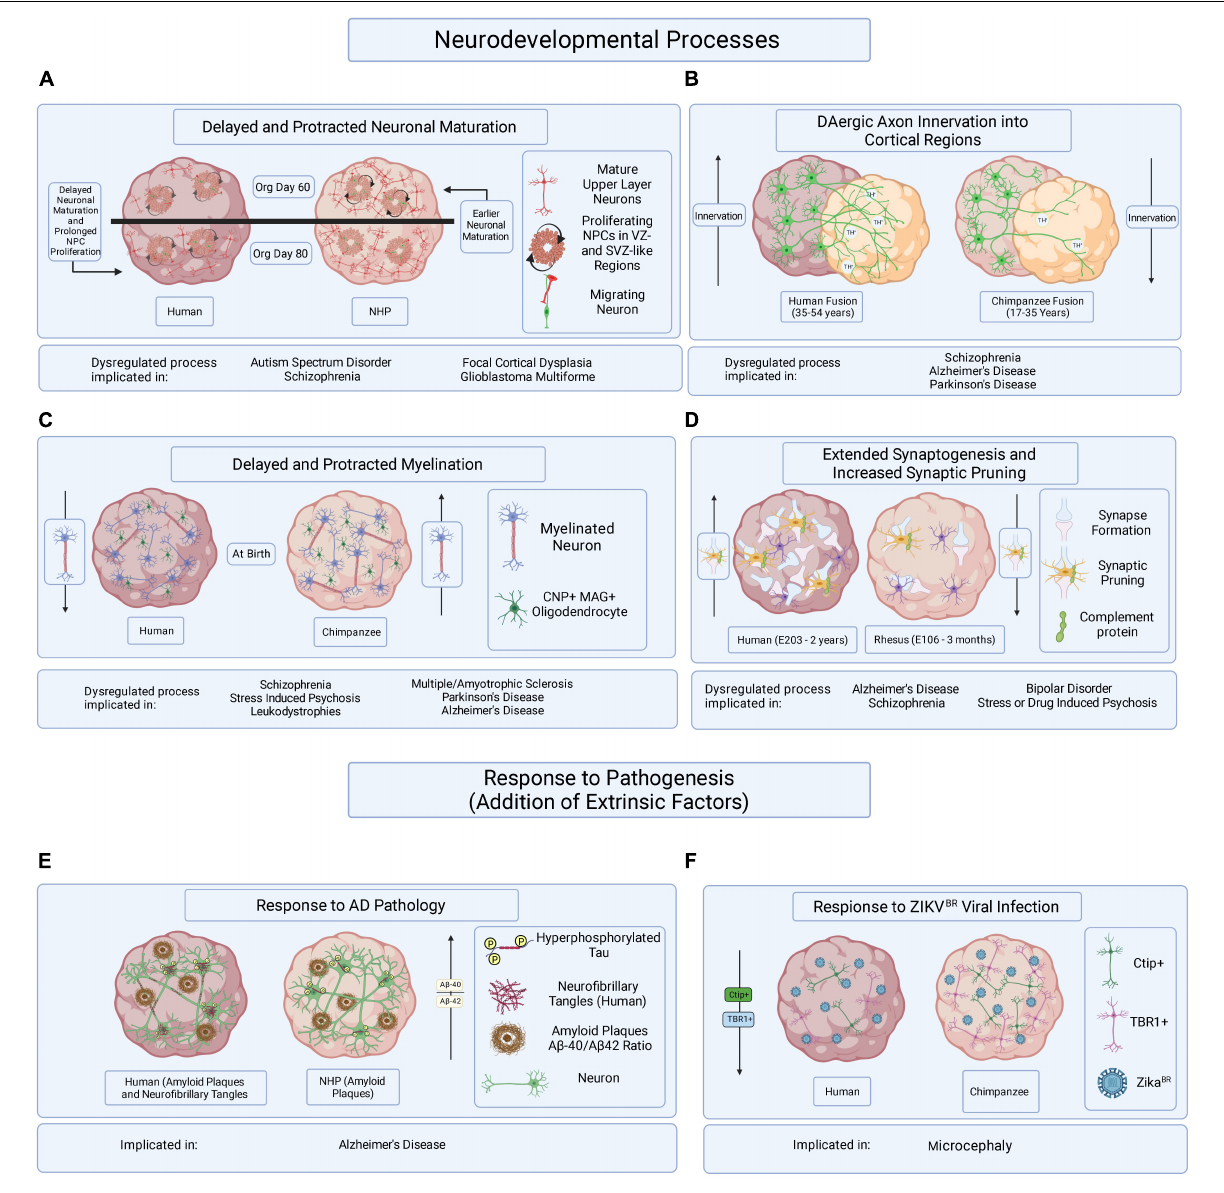
FIGURE 2 | Hypothesized brain organoid-based models of human specific processes implicated in brain disease etiology and progression. Schematic illustrating multiple processes of human-specific brain development or responses to pathogenesis compared to those of NHPs and represented in brain organoids. (A) Delayed neuronal maturation and prolonged NPC proliferation have been observed in human brain organoids when compared to chimpanzee derived brain organoids. The dysregulation of NPC proliferation and neuronal maturation during brain developed has been linked to ASD, SZ, focal cortical dysplasia, and glioblastoma multiforme. Org is organoid. (B) It might be possible to observe differences in DAergic axon innervation between human and NHPs by fusing cortical organoids to organoids enriched in dopaminergic neurons. The disruption of DA regulation systems has been implicated in SZ, AD, and PD. Timepoints reflect observations of DAergic axon innervation in certain regions of the cortex comparing human and chimpanzee postmortem tissue samples. (C) Delayed and protracted myelination has been observed in human when compared to chimpanzee pre- and postnatal postmortem tissues and the disruption of axonal myelination is linked to SZ, stress induced psychosis, leukodystrophies, MS, PD, and AD. Axonal myelination might be compared in primate organoids containing CNP/MAG + oligodendrocytes. (D) Observing periods of synaptogenesis followed by the pruning of excessive synapses in organoids containing microglia could reveal species-specific mechanisms of neuronal maturation when comparing primate organoids. Dysregulated synaptogenesis and synaptic pruning are implicated in AD, SZ, BD and stress and drug induced psychosis. E is embryonic day and timepoints correspond to observations in postmortem tissue. (E) It has been suggested that some aging NHPs develop amyloid-beta plaque deposits but only develop NFTs in rare cases. The overexpression of hyperphosphorylated tau, a precursor of NFT accumulation, in brain organoids derived from humans and NHPs could allow for the identification of species-specific responses to the disease burden. (F) Neurotrophic viral infection, like ZIKV BR infection, can and has been compared among primate species by establishing human and NHP derived brain organoids, infecting them with neurotrophic viruses, and observing resulting differences in pathogenic responses or viral mechanisms of infection. The mentioned implicated brain disorders or processes are not